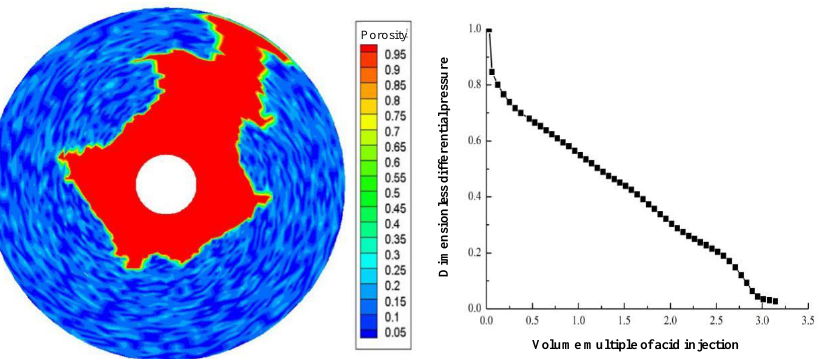
Figure 1. Change of dissolution form and differential pressure with gelling acid injection volume (gelling acid injection speed 0.0065 cm/min).